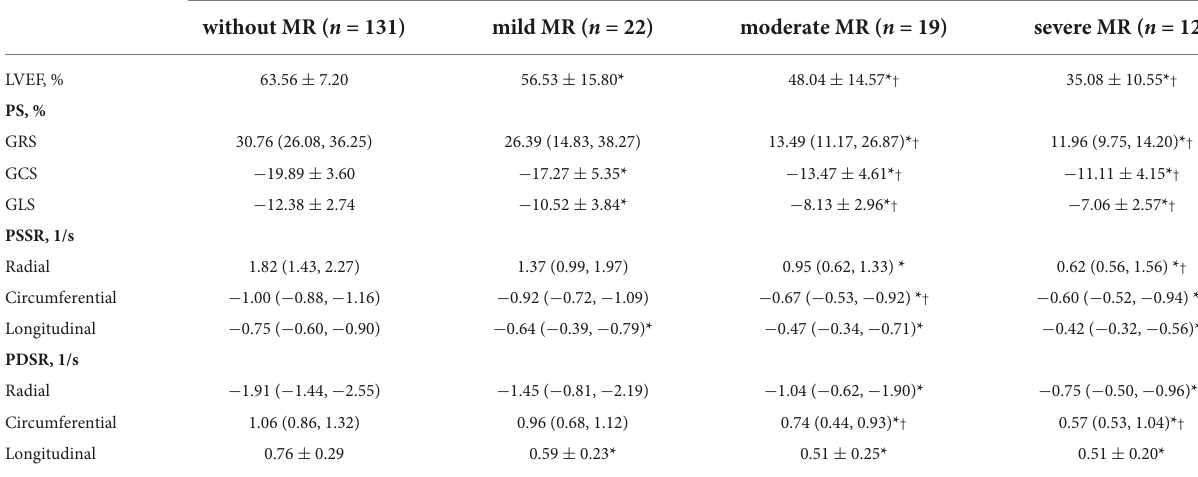
TABLE 3 Comparison of LV strain in hypertensive cases with different degrees of regurgitation.